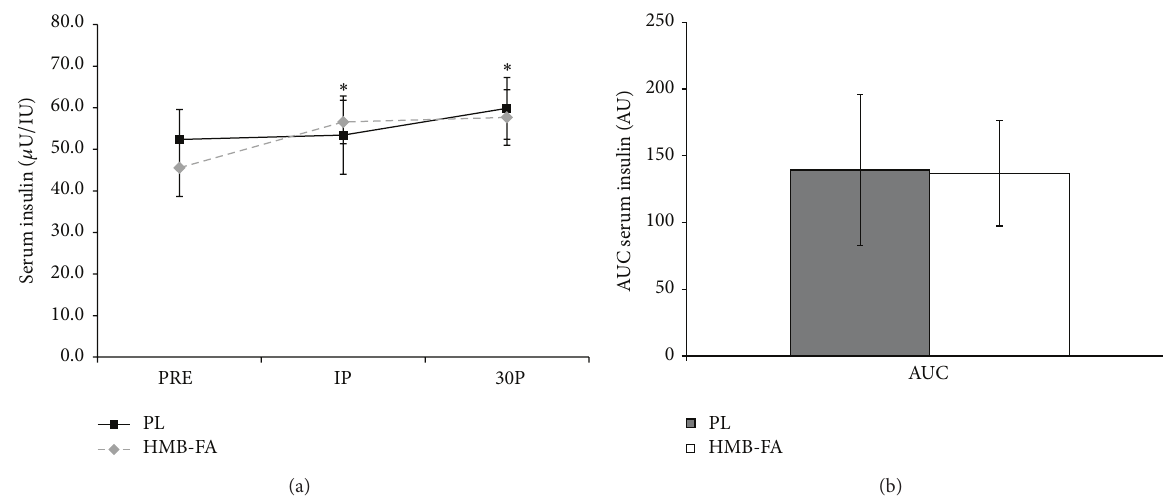
Figure 4: (a) Serum insulin concentration values for placebo (PL) and 𝛽 -hydroxy- 𝛽 -methylbutyrate free acid (HMB-FA) groups before exercise (PRE), immediately after exercise (IP), and 30 minutes after exercise (30P). ∗ Both groups significantly elevated from PRE ( 𝑃 ≤ 0.01 ). (b) Area under the curve (AUC) analysis for serum insulin levels for PL and HMB-FA groups. Data were reported as mean ± SD.